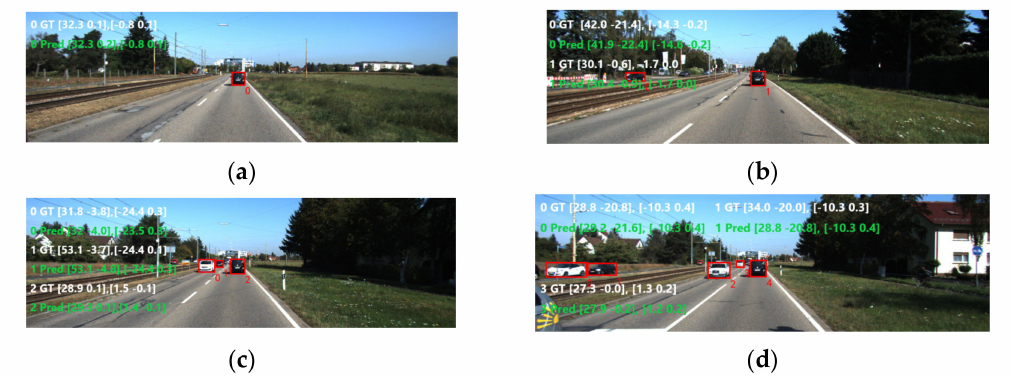
Figure 5. Qualitative visualization results on the KITTI dataset. Figures ( a – d ) respectively represent the vehicle ahead, the oncoming vehicle, the multi-vehicle in front, and the multi-vehicle in the opposite